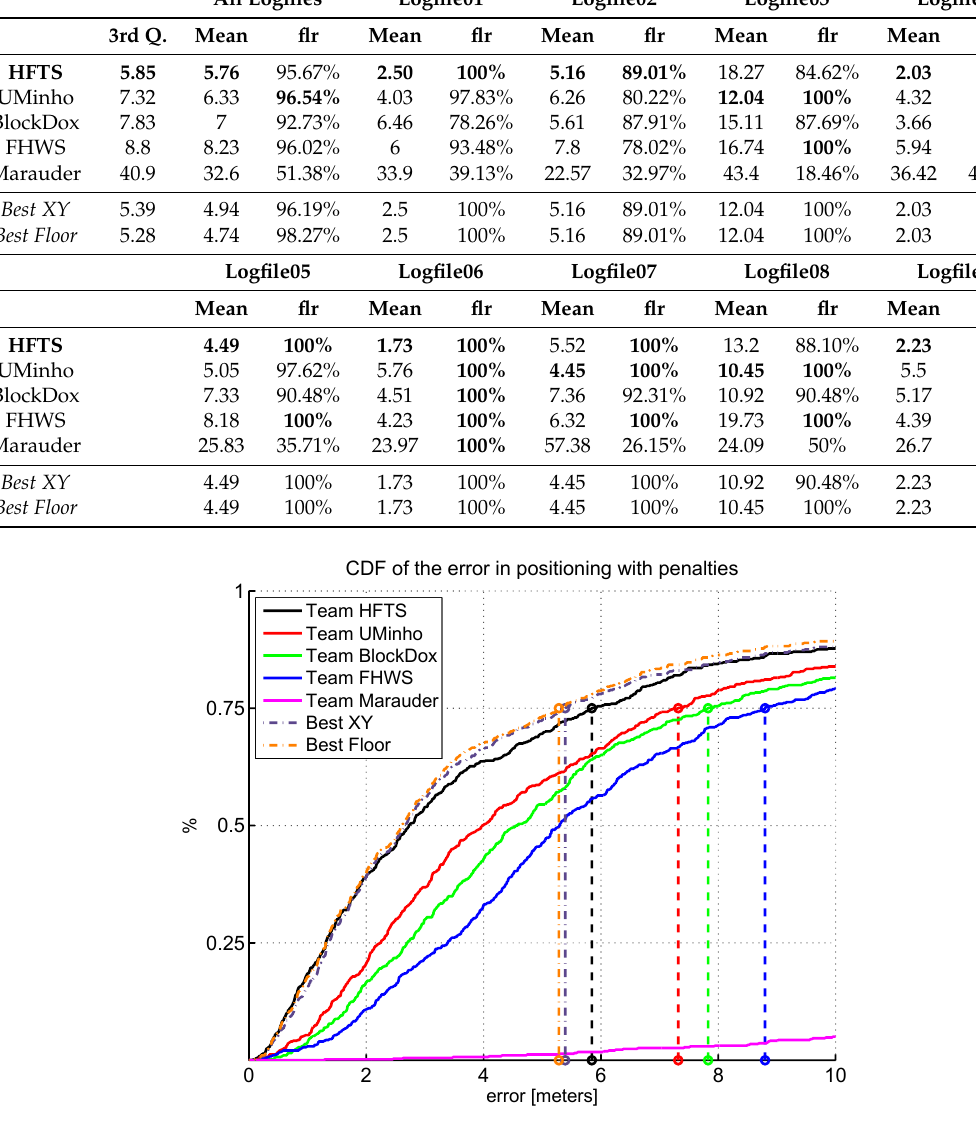
Figure 3. Cumulative distribution function (CDF) of the positioning error plus floor/building penalties obtained by each